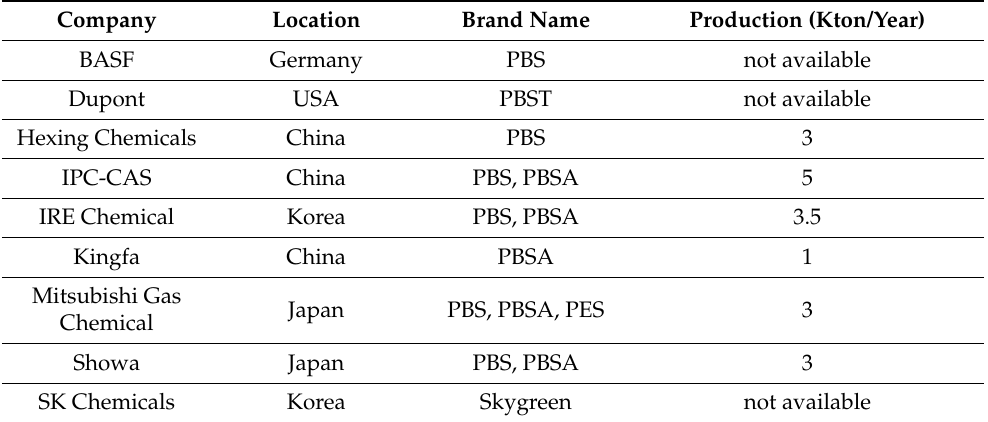
Table 1. Global producers of PBS (Reprinted with permission from Reference [57] Copyright 2020